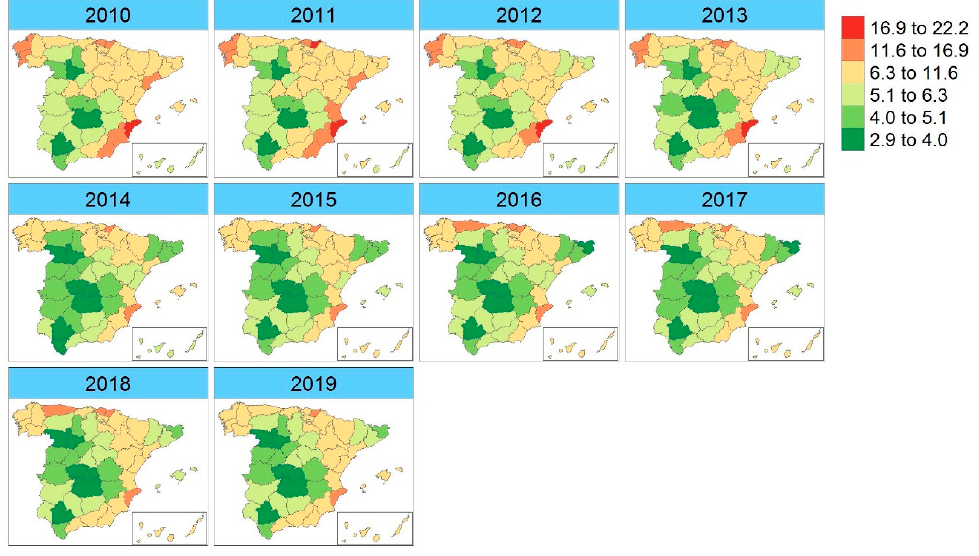
Figure 3. Maps showing the posterior mean estimates of tractor fatality rates per province and year.